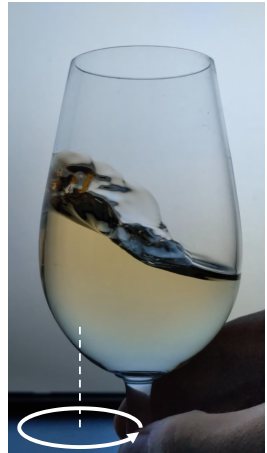
Figure 1. Liquid wave traveling along the sides of a wine glass subsequent to typical manual rotation of the glass conducted with the foot of the glass in full contact with a flat support